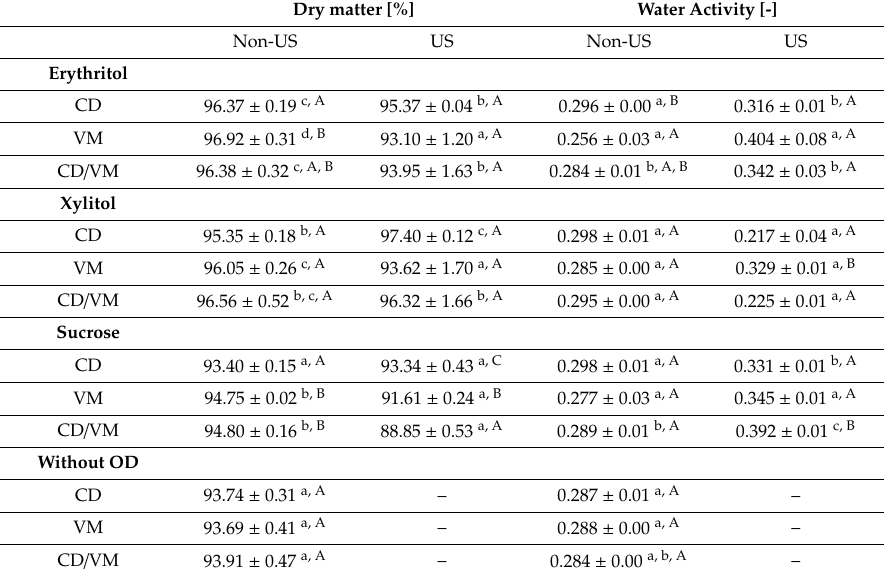
Table 2. Dry matter and water activity in dried apple samples. Means within one column with a di ff erent letter superscript are significantly di ff erent – homogeneous groups ( p < 0.05). Lowercase (a,b and c)—factor: osmotic substance / without OD, among the same drying method; uppercase (A,B and C) – factor: drying method, among the same osmotic